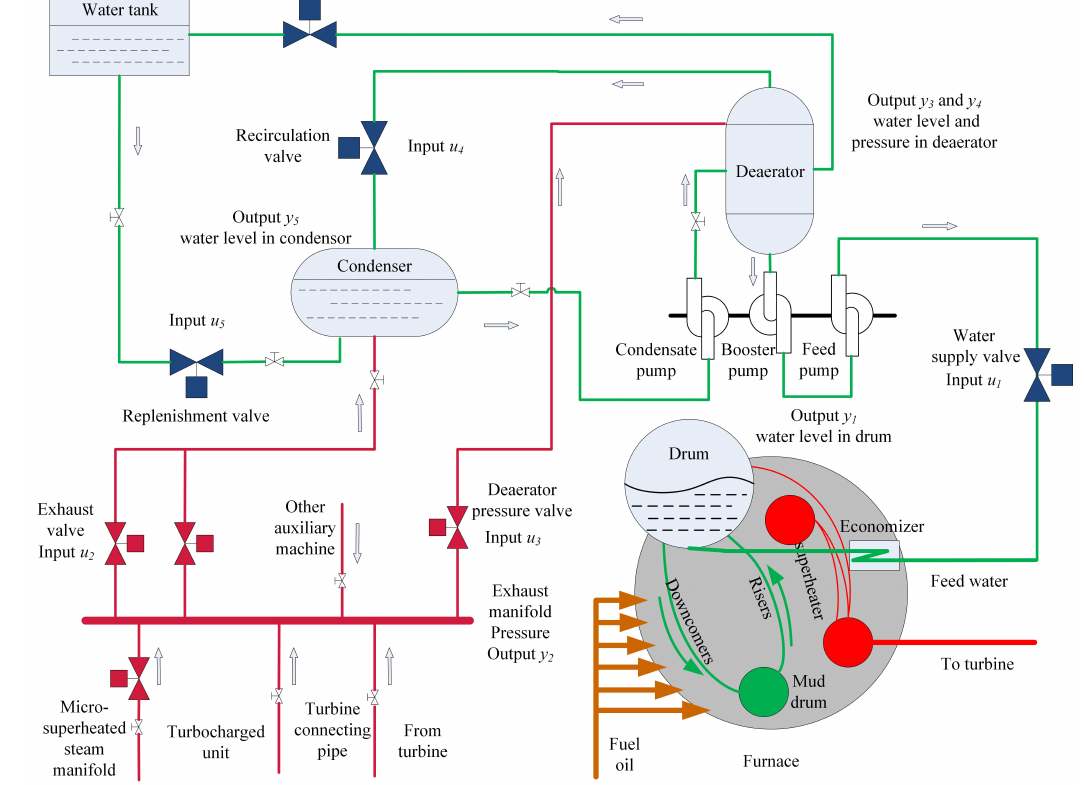
Figure 1. Structure of the steam/water loop [25] (reproduced with permission from Zhao, S.; Maxim, A.; Liu, S.; De Keyser, R.; and Ionescu, C, Processes; published by MDPI, 2018.). In the steam/water loop, the input variables u = [ u 1 , u 2 , . . . , u 5 ] are valves for the five sub-loops, and the output variables y = [ y 1 , y 2 , . . . , y 5 ] are the drum water level ( y 1 ), exhaust manifold